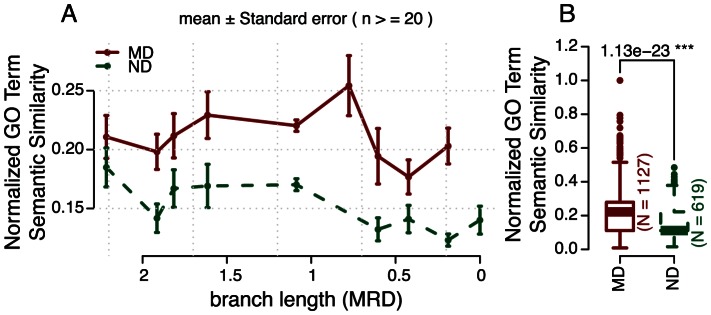
Evidence for pervasive functional redundancy in duplicated disease genes based on Gene Ontology annotations.Compared with duplicated non-disease genes (ND) of similar duplication age (represented by branch length, see Methods), monogenic disease genes (MD) tend to have A) higher functional similarity according to Gene Ontology annotations with their most recent duplications (MRDs; p-value = 7.77×10−5, Hypergeometric Distribution test); B) the same are also true when duplication ages are omitted (Wilcoxon Rank Sum Test).